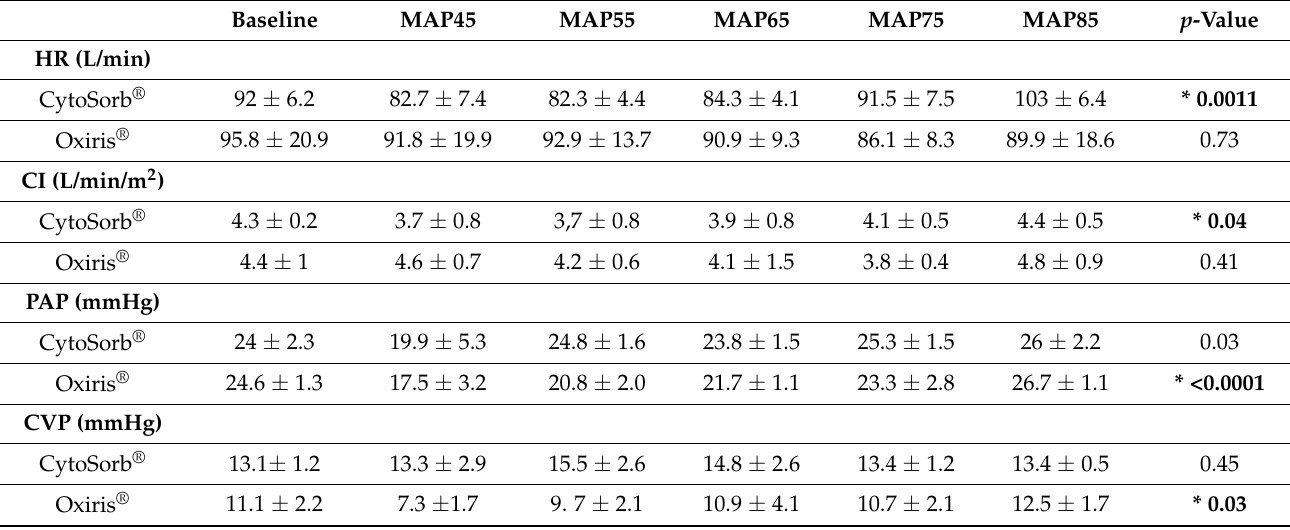
Table 1. Systemic hemodynamic